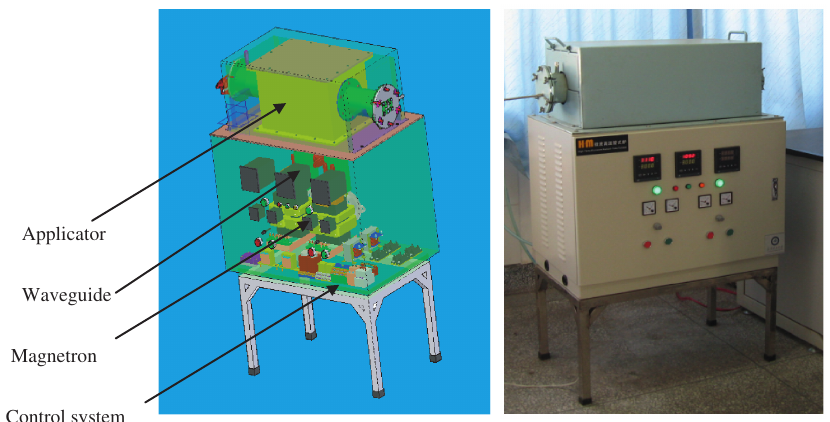
Figure 1: Schematic diagram (left) and photo (right) of the microwave heating